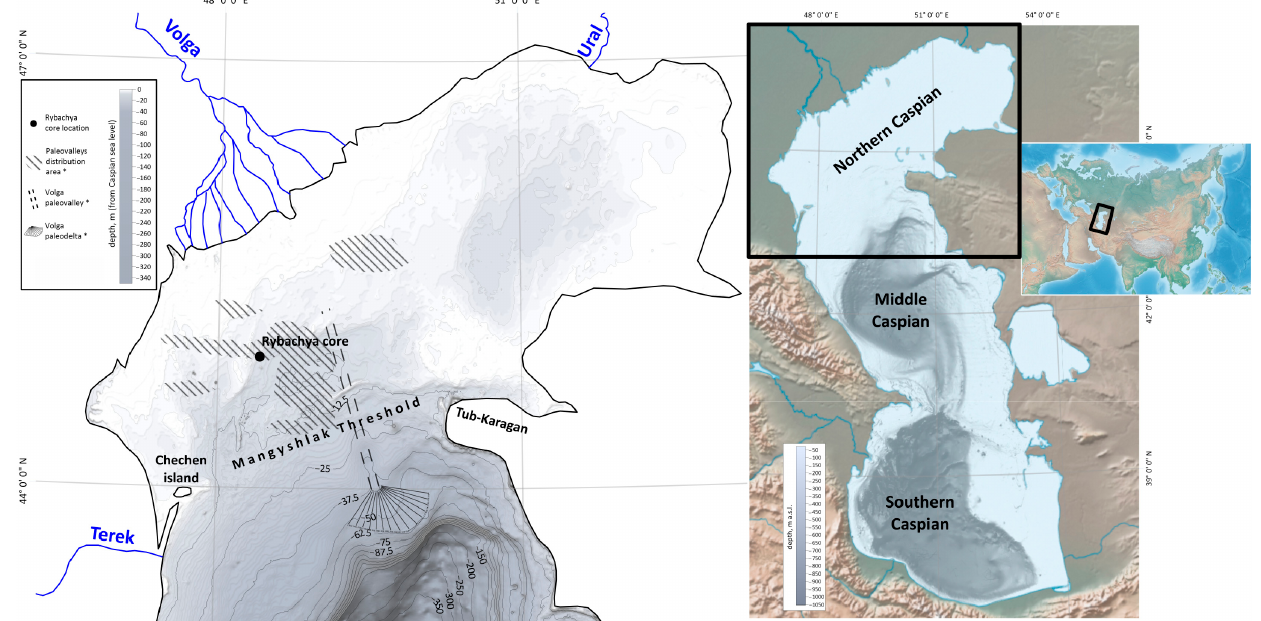
Figure 1. Geographic location of the studied Rybachya core (the bottom surface is hill-shaded). * According to Bezrodnykh and Sorokin, 2016 [19].